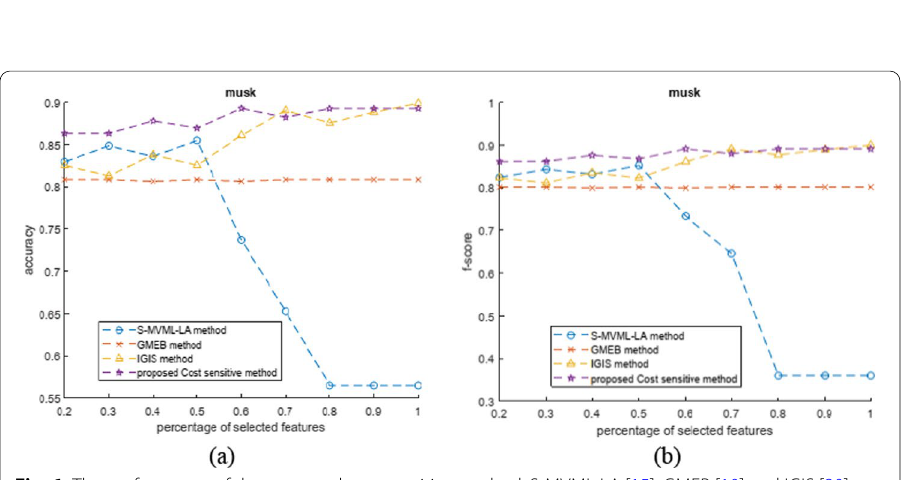
Fig. 6 The performance of the proposed cost sensitive method, S-MVML-LA [15], GMEB [10] and IGIS [20] versus the changes in percentage of selected features numbers on the musk dataset. a Accuracy, b f-score